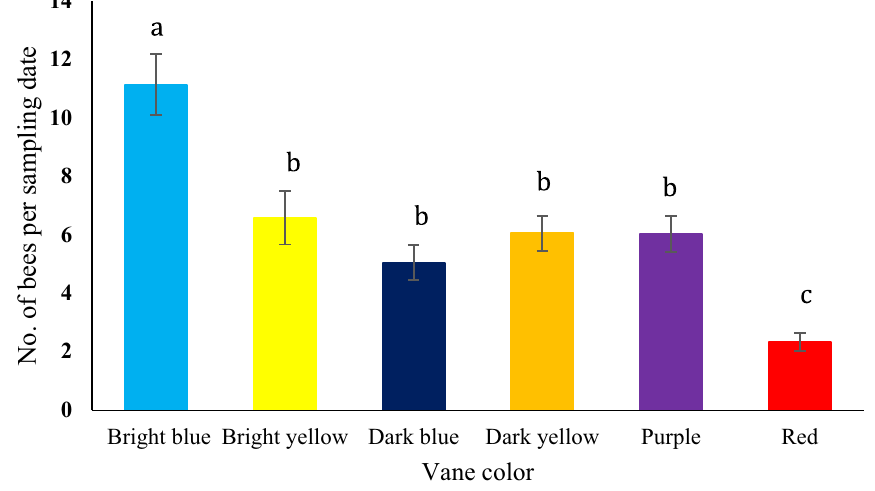
Figure 2. Differences in capture rate (least squares means ± SE) of bees in passive traps with six different colored vanes (bright blue, bright yellow, dark blue, dark yellow, purple, red) in livestock pasture system.